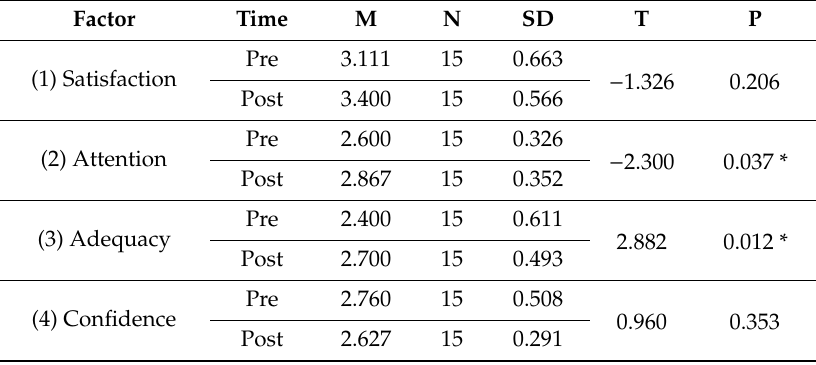
Table 12. Analysis result of difference between pre- and post-scoring incentives of control group. Factor